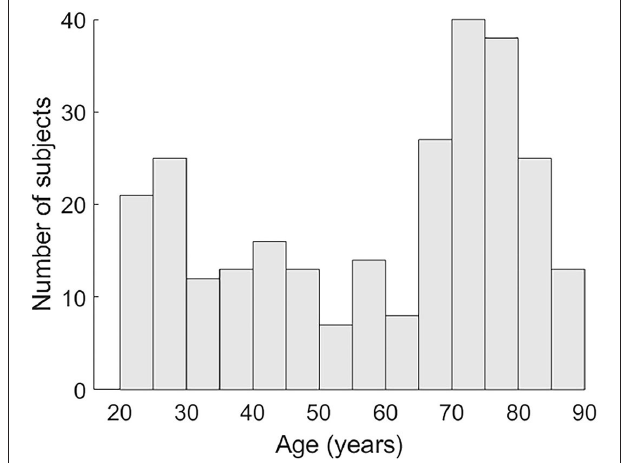
FIGURE 1 | Age distribution of